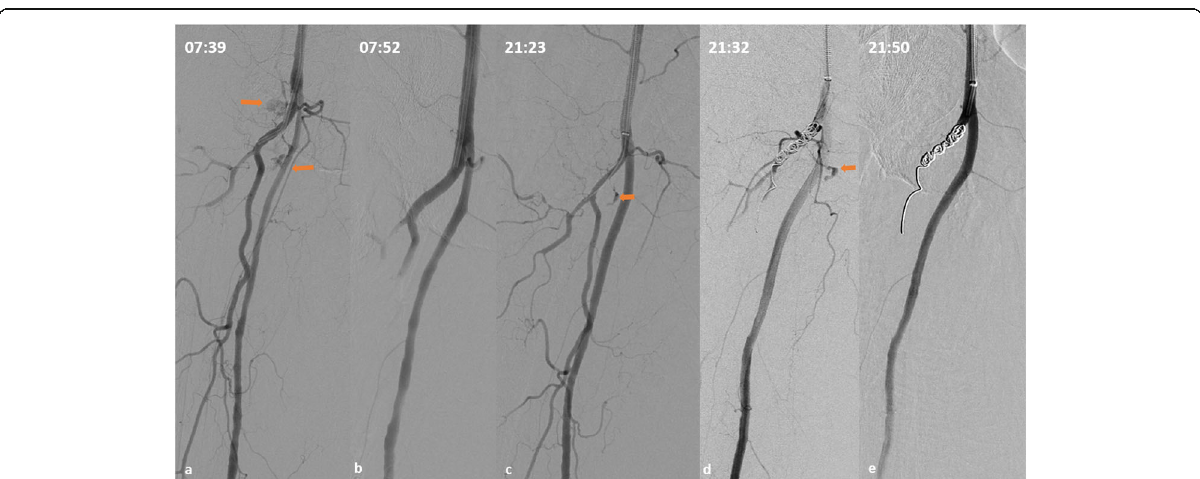
Fig. 2 The single case of rebleeding. An 87-year old female patient with acquired factor VIII deficit, aPTT 164.1; INR 1.8 and spontaneous bleeding of a right deep femoral artery branch, causing significant Ht/Hb decrease and hemodynamic instability. a Selective DSA demonstrating two sites of active extravasation from branches of the DFA. b Final DSA following gel foam embolization. c Selective DSA approx. 13 h after first embolization demonstrating rebleeding from one of the previously embolized bleeding sites (arrow). aPTT is now prolonged. d Persisting active bleeding through the coils, approx 5 min after their deployment. e Final DSA demonstrating successful hemostasis following further